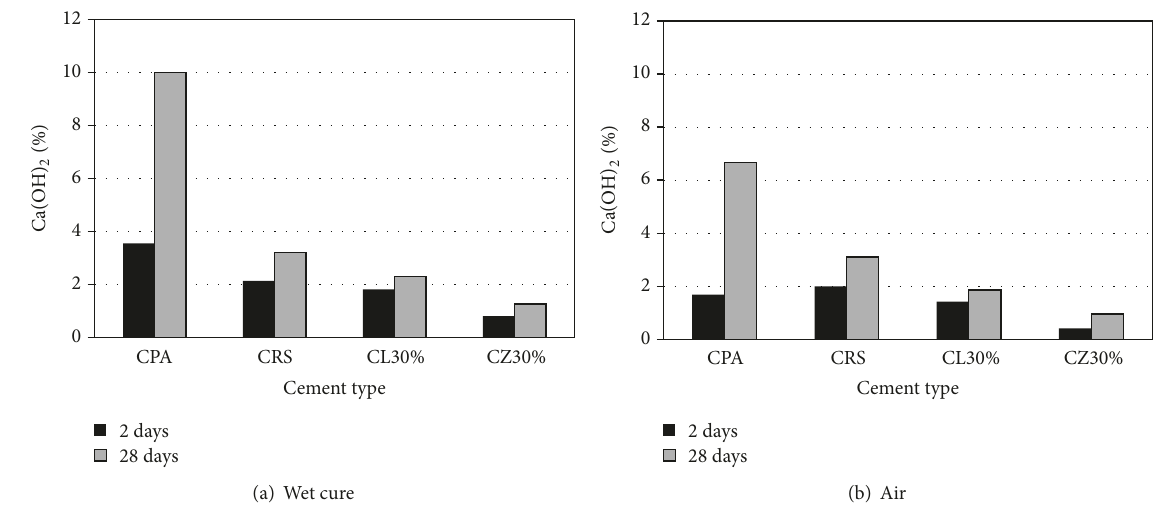
Figure 10: (a), (b) The content of retained portlandite in cement paste in wet cure and left in the air for 2 days.